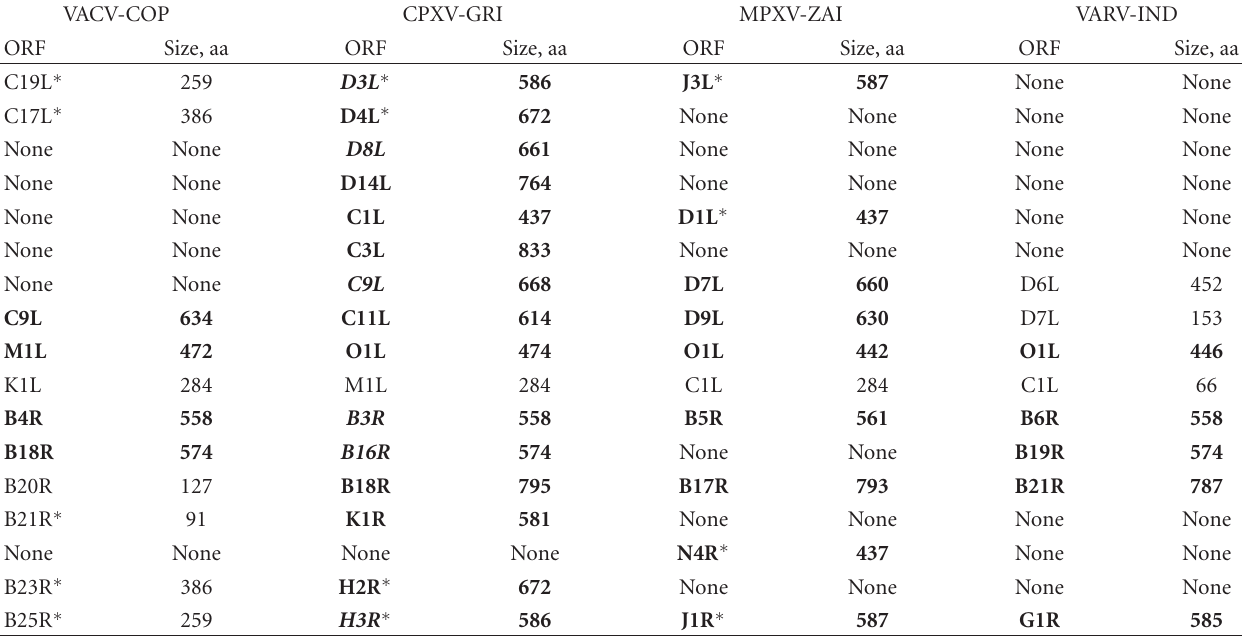
Table 2: Orthopoxviral ankyrin-F-box-like proteins.